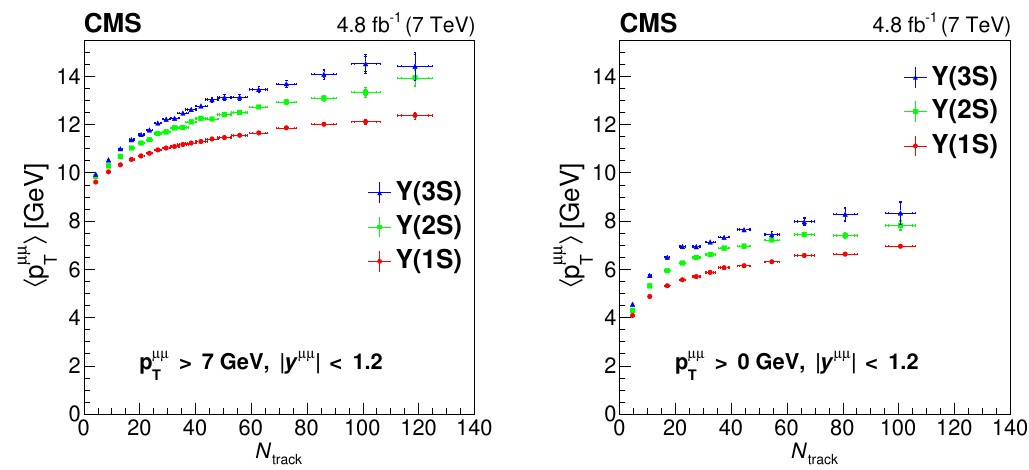
Figure 3 . Mean p (cid:22)(cid:22) (left) and > 0 GeV (right). The outer vertical bars represent the combined statistical and systematic uncertainties in the ratios, while the horizontal bars give the uncertainty in Inner tick marks show only the statistical uncertainty, both in the ratio and in